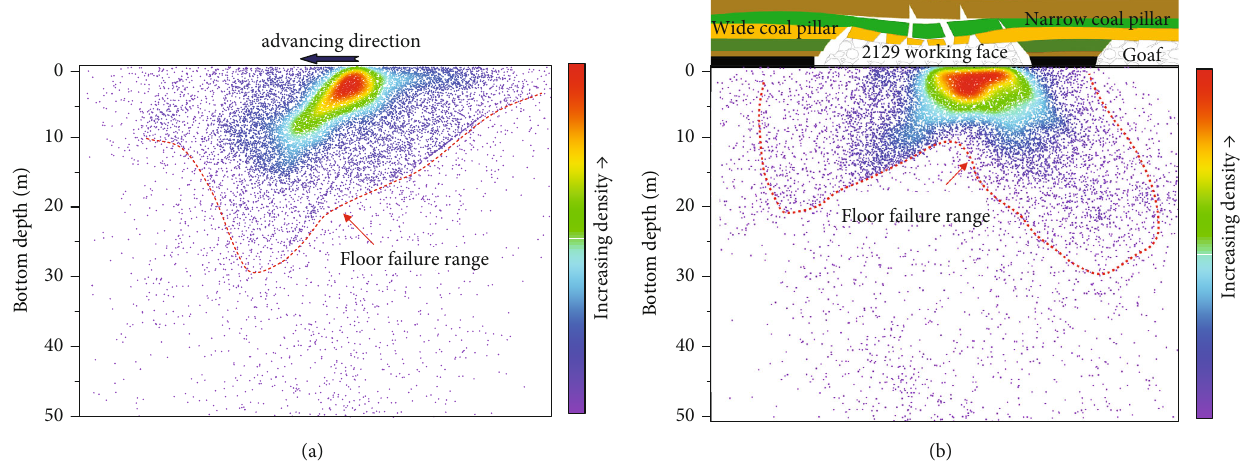
Figure 12: Microseismic monitoring results of fl oor failure range after RHF: (a) along the inclination; and (b) along the strike.